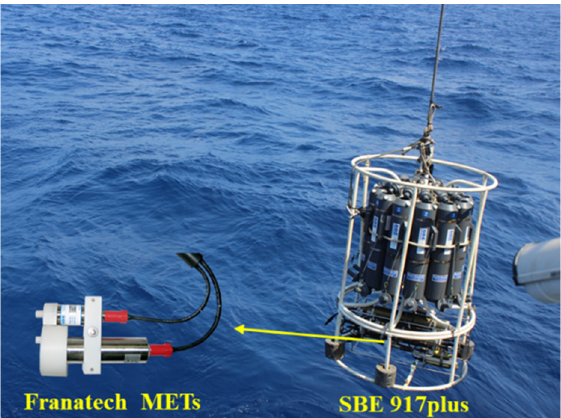
Figure 4. CTD system and METs.